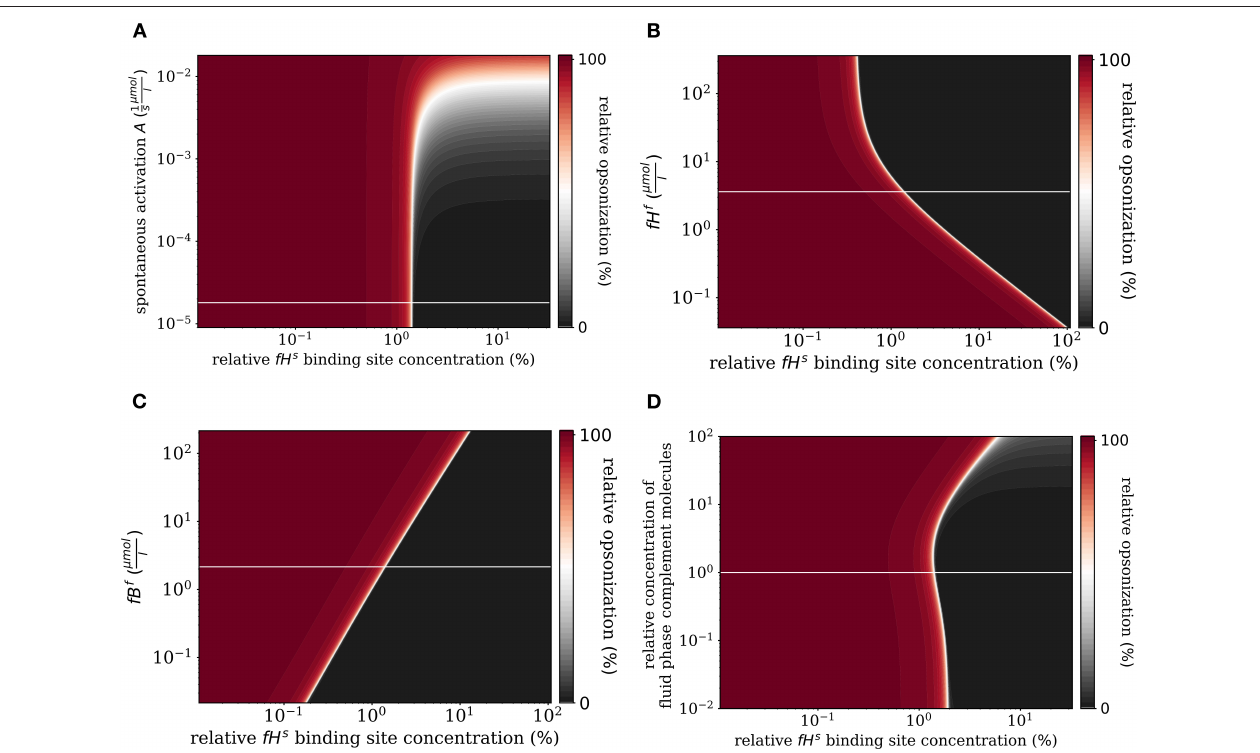
FIGURE 6 | Relative opsonization in the steady state for varied system parameters as a function of the relative Factor H binding site concentration. The white line indicates the DynaCoSys model for standard parameter values. (A) Variation of the spontaneous C3b f activation A , (B) variation of the fH f concentration, (C) variation of the fB f concentration, and (D) variation of the relative concentration of complement molecules in the fluid